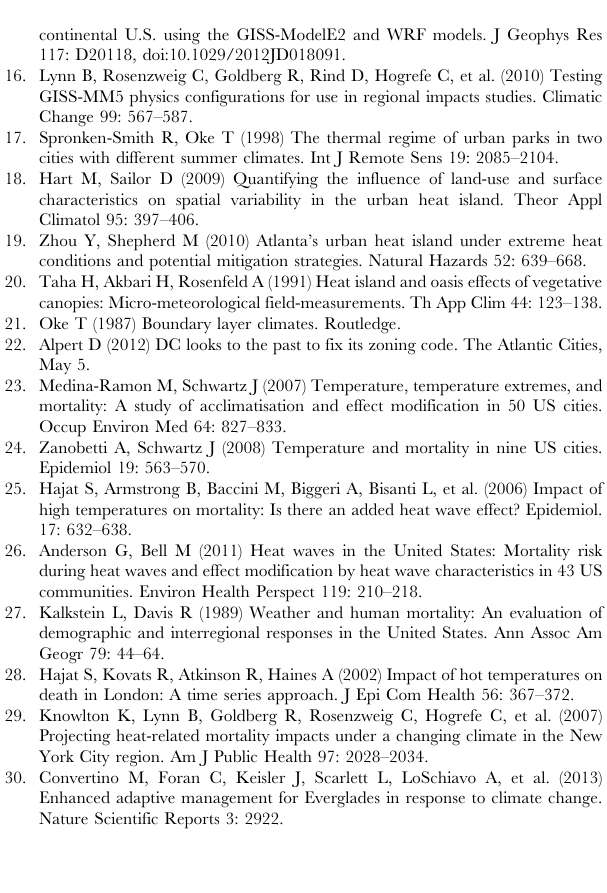
Figure S1 Uncertainty in WRF model initializations by temperature metric and MSA. Error bars display confidence intervals around mean warm season temperatures (AvgT,